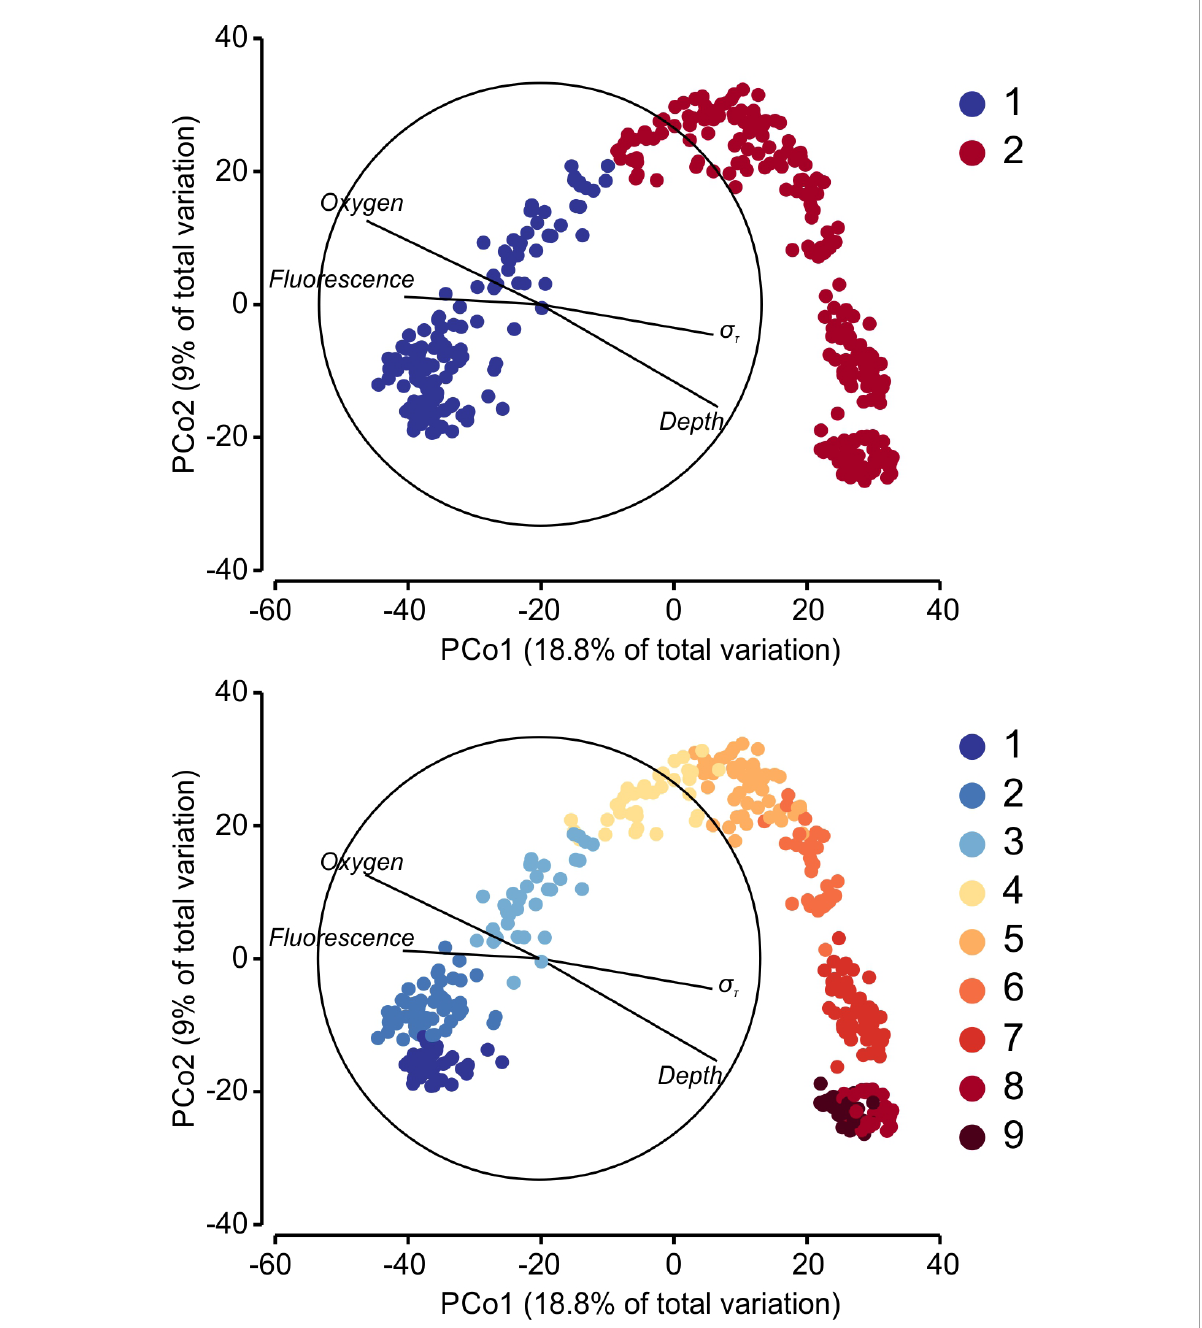
FIGURE 3 PCoA ordination of all samples for the fi rst two axis, based in their community composition and using Bray-Curtis distances. Environmental factors over are overimposed as vectors, with length corresponding to the correlation r . The circle represents r =1. Colors indicate the non- hierarchical cluster for each sample, for K =2 (upper panel) and K =9 (lower